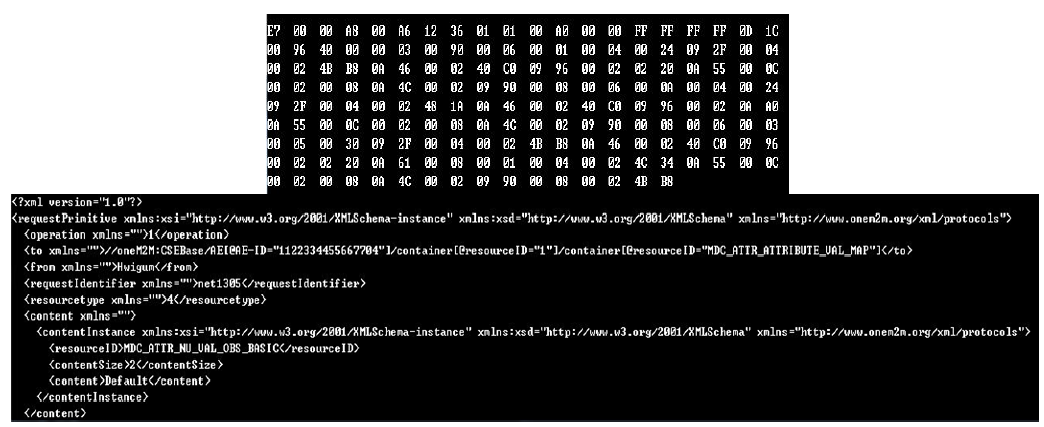
Figure 16. Screen captures of connection establishment (Conversion of a oneM2M Retrieve primitive Response message into an ISO/IEEE 11073 Association Response message).